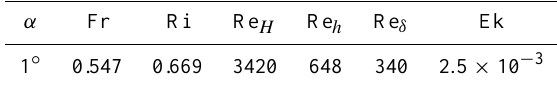
Table 2. Non-dimensional parameters in